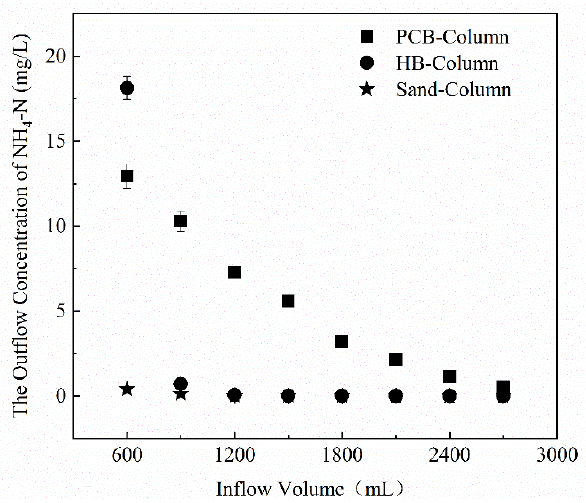
Figure 7. Concentration of NH 4+ in effluent from the PCB-Column, HB-Column and Sand-Column. To evaluate whether the previous leaching experiments could be used to estimate the stormwater infiltration effluent, the estimated (calculated in leaching experiments) and detected concentrations (calculated in column experiments) are listed in Table 4 for comparison. The estimated concentrations were based on the assumption that the PCB and HB in the columns would release the same quantities of ammonium as in the leaching experiments. Furthermore, 626.73 g of PCB and 834.94 g of HB were added to the two columns, respectively. According to the assumption of the same leaching quantities, it was assumed that after 40 min of pumping in DW, the first 50 mL of effluent NH 4+ concentrations of the two columns should be 50.45 and 3.12 mg/L. However, in reality, the NH 4+ concentration of the PCB-Column was far lower than the estimated value, and so was the total leaching amount. The HB-Column showed abnormalities, and the detected concentration of NH 4+ was 3.8–5.81 times the estimated value. It is predictable that the detected concentration and the total release quantities of NH 4+ were lower than the estimated. During the infiltration process, it had smaller contact surface and less time between filters and DW than in the leaching experiments [37]. What is more, the hydraulic power of the leaching experiments was stronger than that of the infiltration process, which led to the insufficient dissolution and low dissolution rate of the ammonium, and ulteriorly the detected value would be lower than the estimated value. The abnormality of the HB-Column may be caused by the negative charges on the surface of the biochar. The charges promoted the leaching of NH 4+ which should have adhered to the surface of the additive fillers and was easily washed away [38]. In general, the results of the leaching experiments would overestimate the quantities of ammonium leaching and could be considered as a limiting factor for long-term operation